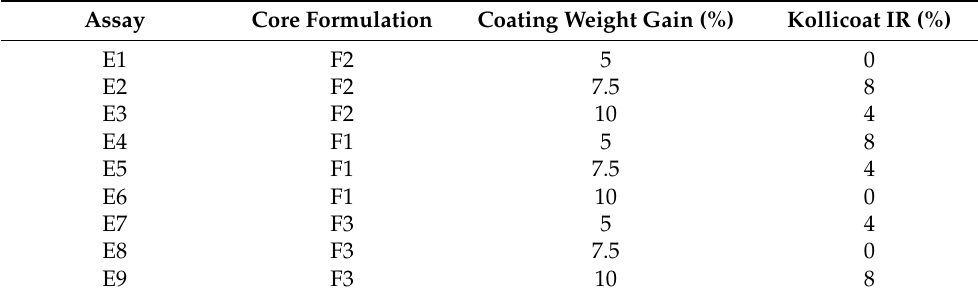
Table 2. Assay matrix for coating mini-tablets—planning carried out using Statistica Program, version 11, 2012 (StatSoft Inc., Tulsa, OK,